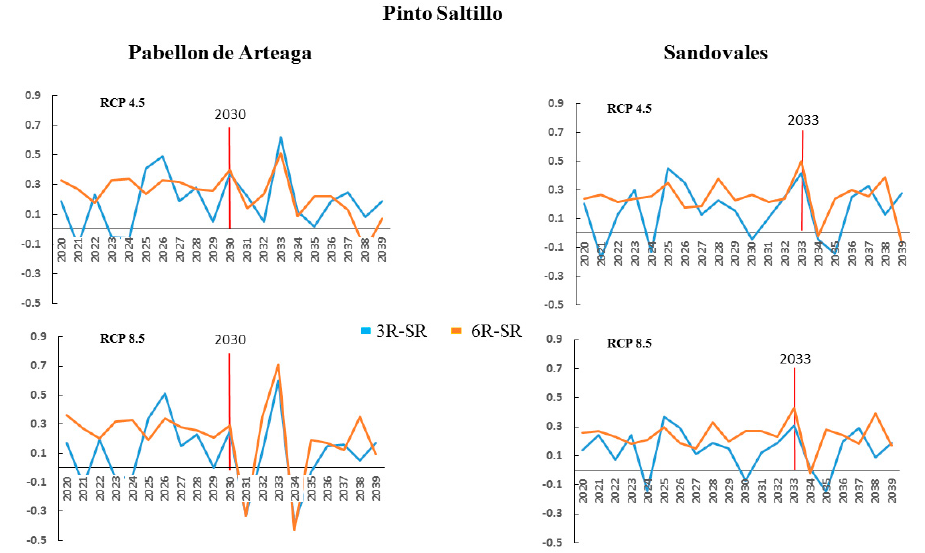
Figure 5. Forecasted seed yield (Mg ha − 1 ) increase or decrease for 2020–2039 under climatic scenarios RCP4.5 and RCP8.5 for Pinto Saltillo common bean cultivar (growth habit III) under sowing densities of 145,000 (3R) and 260,000 (6R) plants ha − 1 , compared to baseline sowing density 90,000 plants ha − 1 (SR) under rainfed conditions in the semi-arid temperate highlands of Pabellon de Arteaga and Sandovales in Aguascalientes, Mexico.